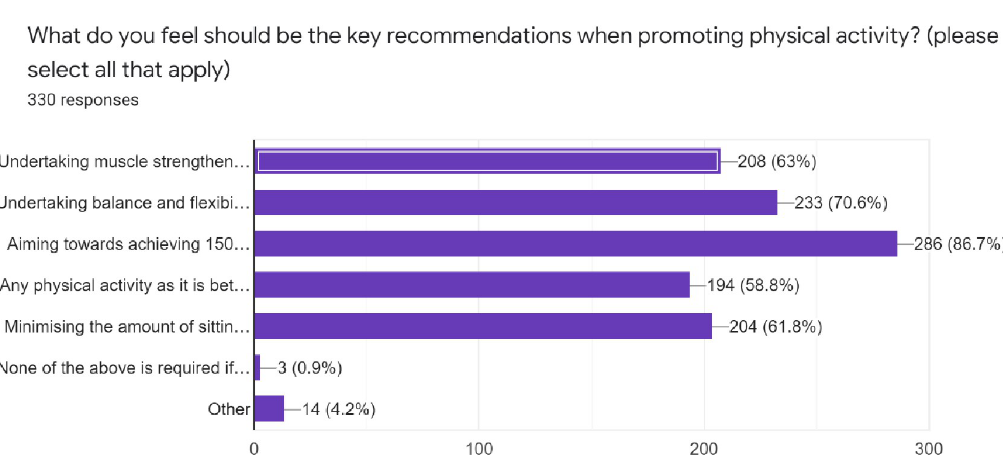
Fig 2. Key recommendations when promoting physical